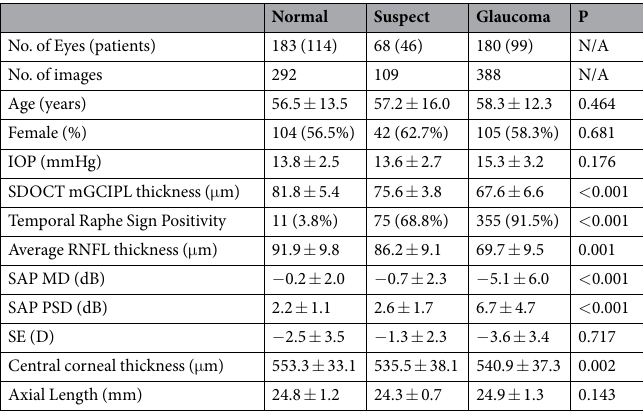
Table 1. Demographic and clinical characteristics of the eyes included in the study. SD-OCT = spectral domain-optical coherence tomography; mGCIPL = macular ganglion cell-inner plexiform layer; dB = decibels; SE = spherical equivalent; D = diopters; SAP = standard automated perimetry; MD = mean deviation; PSD = pattern standard